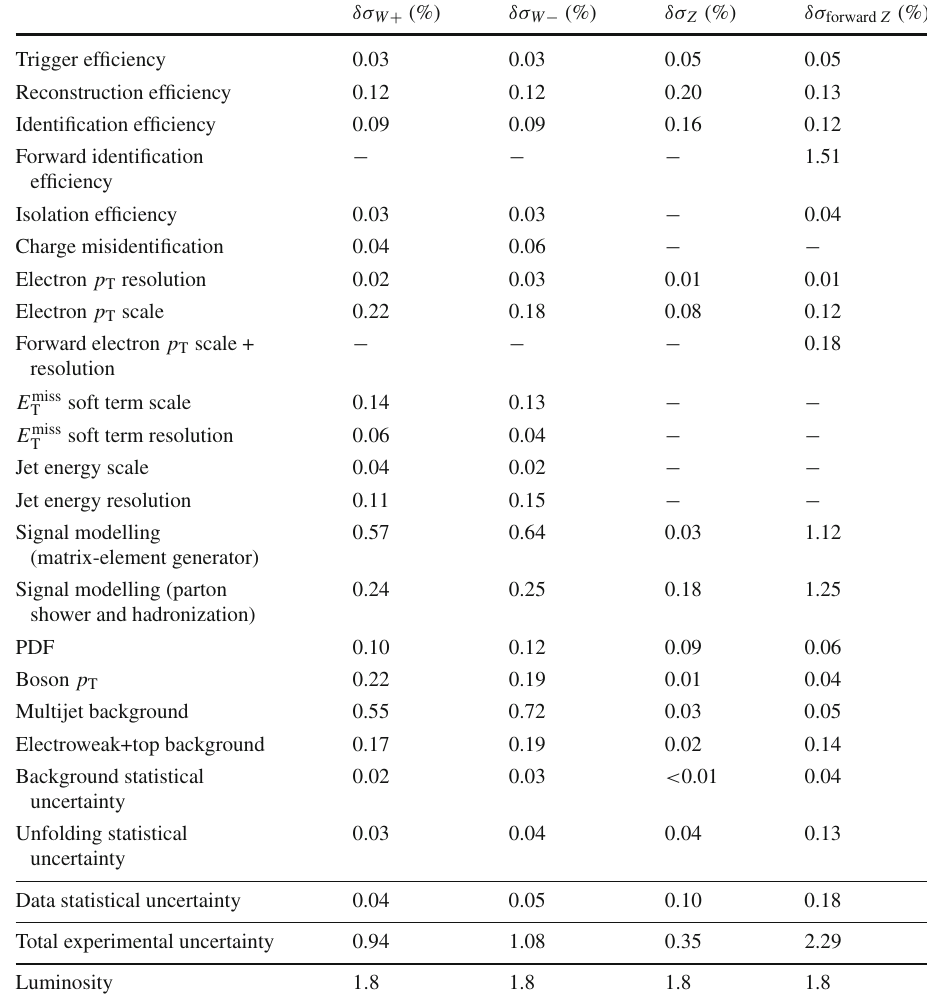
Table 3 Relative uncertainties δσ in the measured integrated fiducial cross sections times branching ratios of W + , W − , central and forward Z /γ ∗ (66 < m ee < 116GeV) in the electron